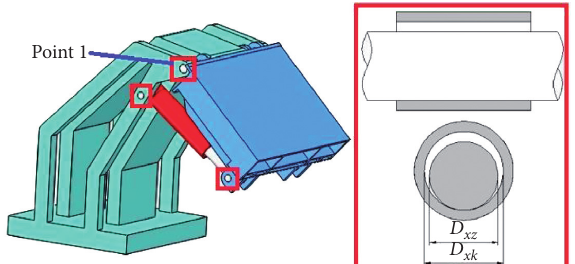
Figure 2: Tail beam structure and its radial clearance structure.